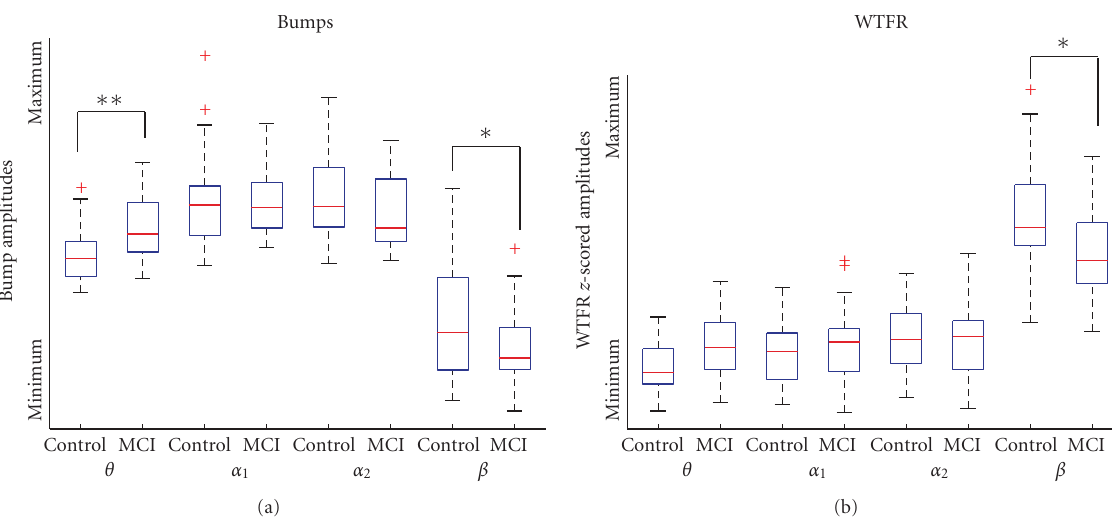
Figure 5: Boxplot comparison of the time-frequency activity between the time-frequency representation and its sparse bump representation. The center line is the median, the box represents the interquartile range, whiskers represent nonoutlier observations, and cross indicates outliers. ∗ and ∗∗ indicate significant ( P < . 01) and very significant ( P < . 001) di ff erences. (The relative power appears larger than in lower ranges. This is due to the topography of the wavelet maps (because we used steps of 1Hz instead of using logarithmic scales). If we resize those values taking into account the size of the ranges, we obtain the same P values and classification results, with a lower power in the beta range as compared to low frequency ranges.)